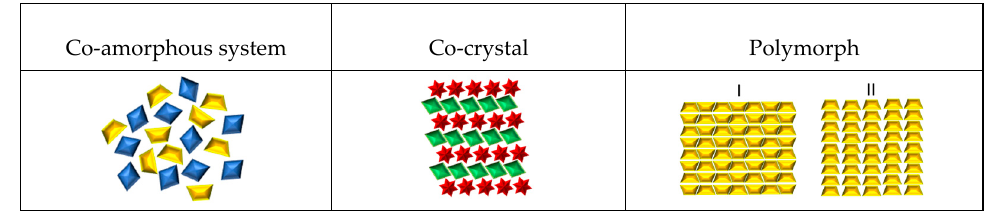
Figure 1. Schematic representation of API formulations: co-amorphous system, co-crystal, and pol-